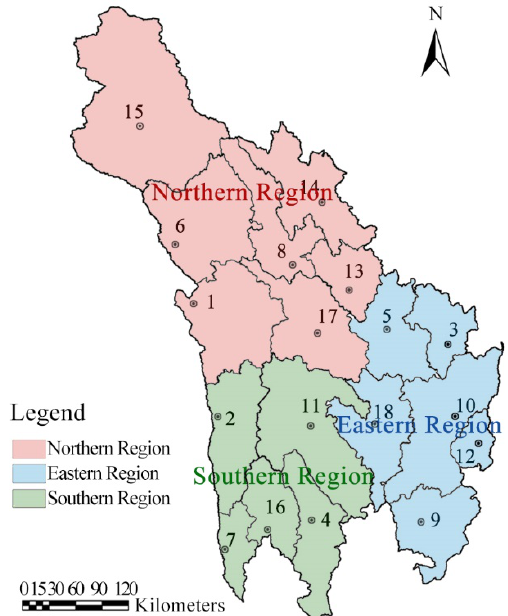
Figure 8. Map of the northern, southern and eastern regions